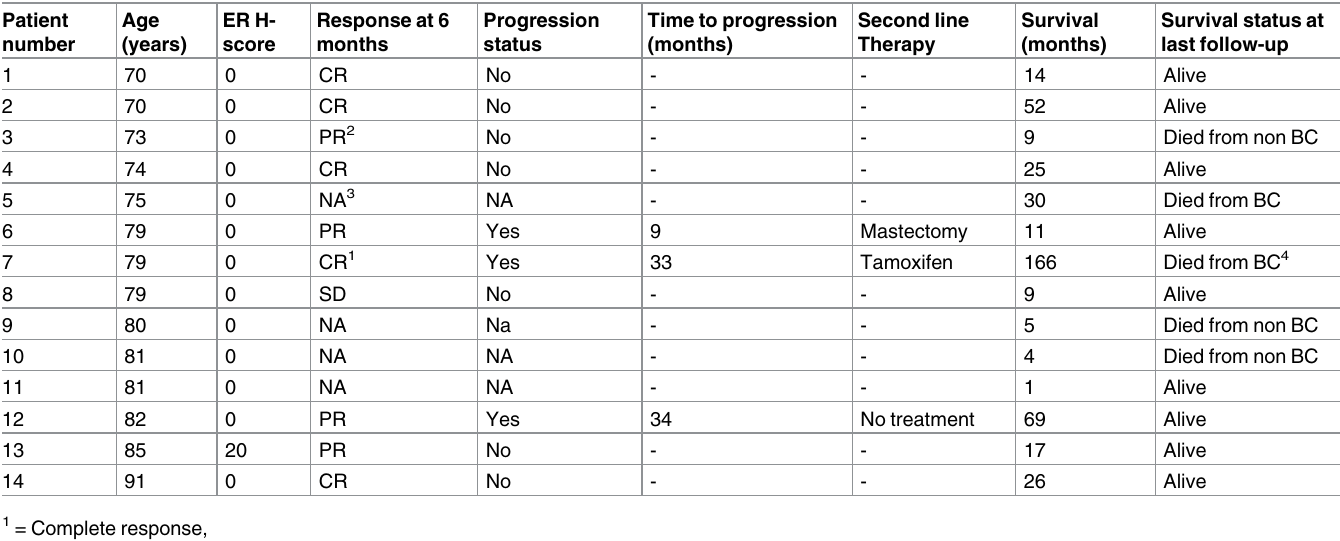
Table 4. Summaryof patients with ER-negative early operable primary breast cancer treated by primary